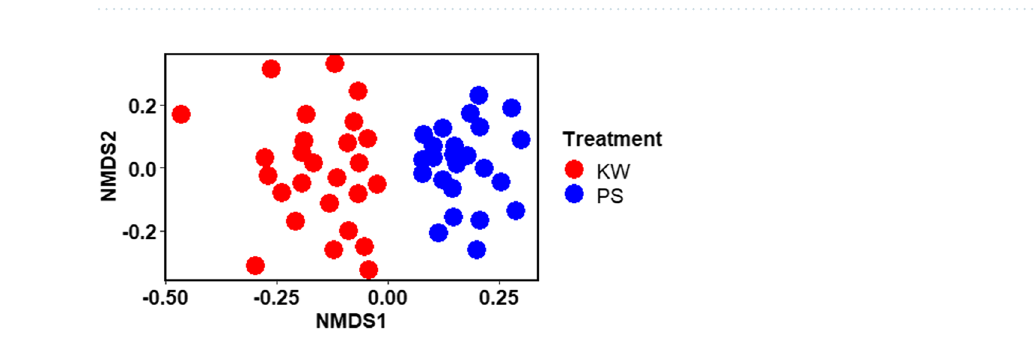
Figure 2. Relative abundances of bacterial taxa associated with permethrin-selected (PS) and parent strain (KW) of Aedes aegypti at ( A ) family and ( B ) genus level.